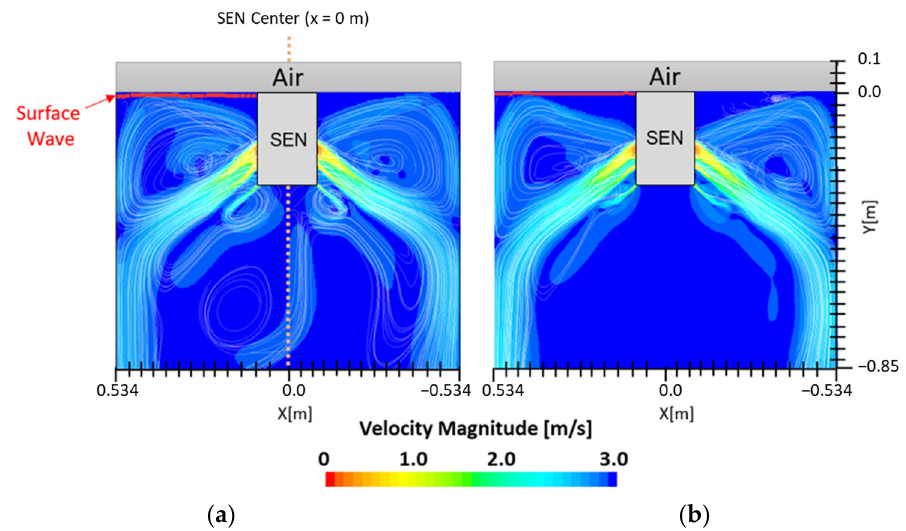
Figure 7. ( a ) Low EMBr strength 2975 G (Case 2) vs. ( b ) high EMBr strength 4350 G (Case 1) flow streamline.